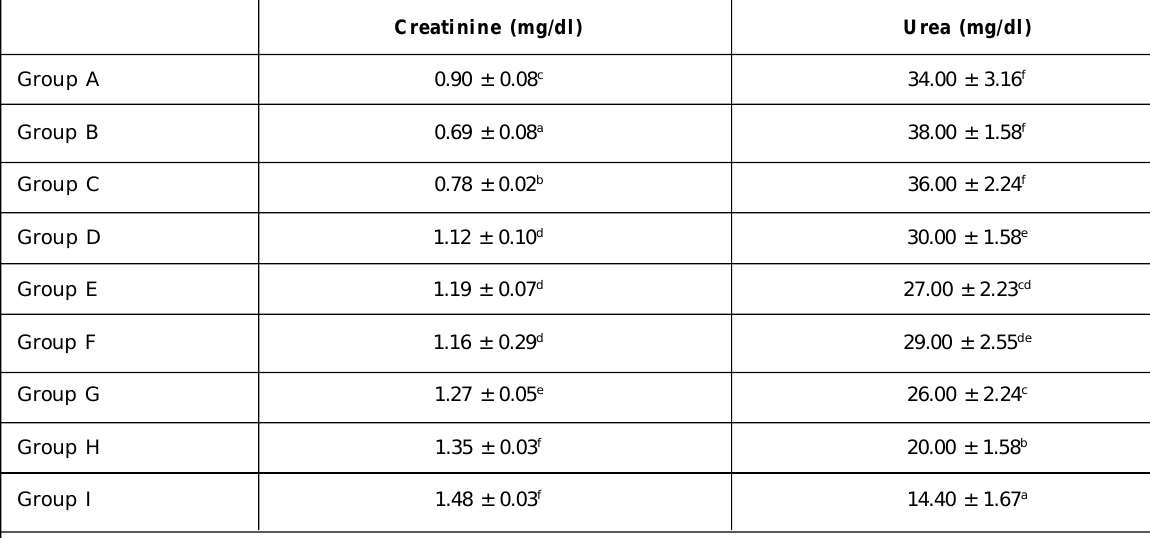
Table 3: Renal function assessment of male albino rats